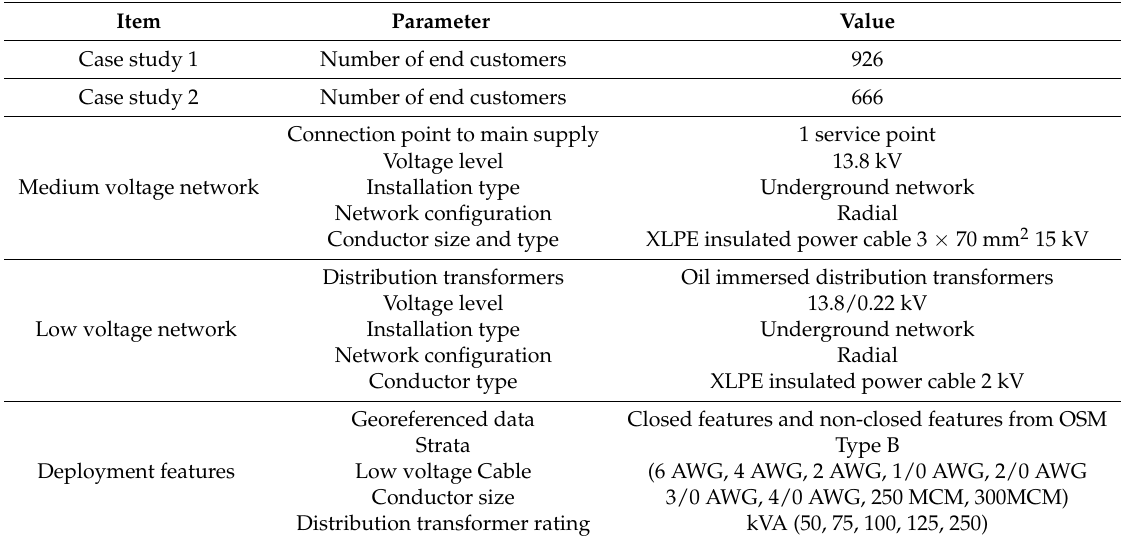
Table 4. Case study parameters and decision-making